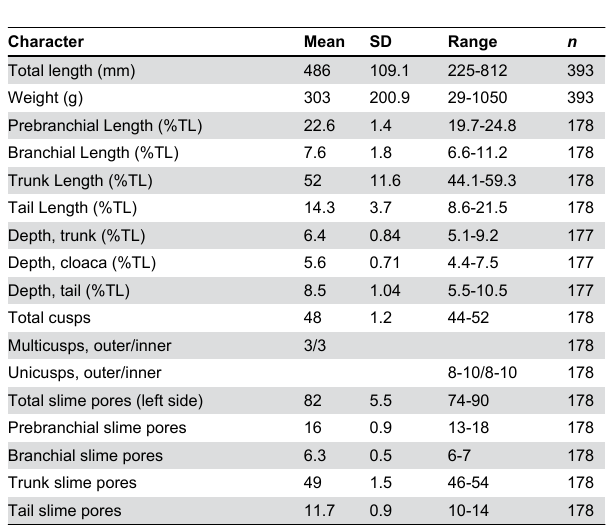
Table 2. Morphological Measurements for Eptatretus cirrhatus